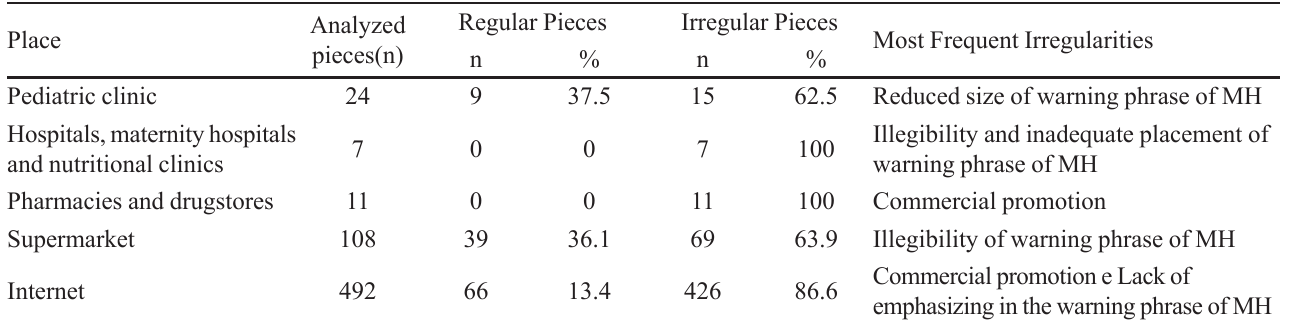
TABLE VI - Percentage of captured and analyzed promotional pieces per collection place and most frequent irregularities concerning RDC # 222